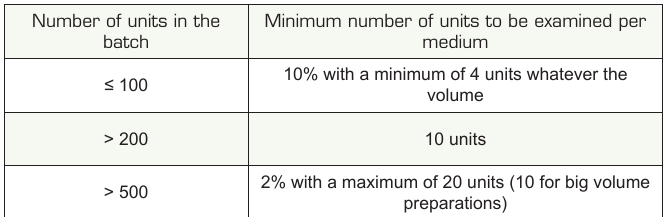
In the special case of ophthalmic preparations, the number of units to be examined respects the indications of table 11.